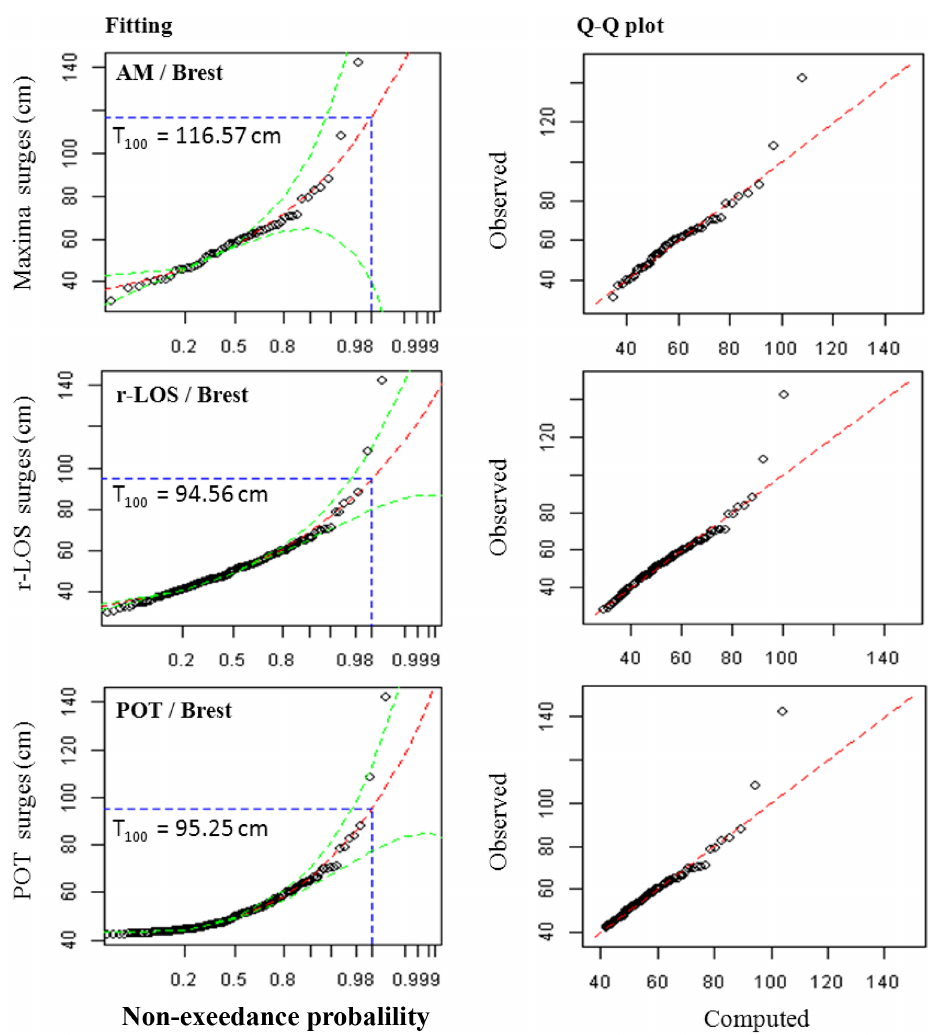
Figure 5. Visual inspection – example of a distribution fit (and Q–Q plot) for Brest station (with outlier) using AM (annual maxima), r - LOS ( r -largest order statistics) and POT (peaks over threshold) methods. The 95% lines correspond to confidence intervals. The T 100 is the 100-years return